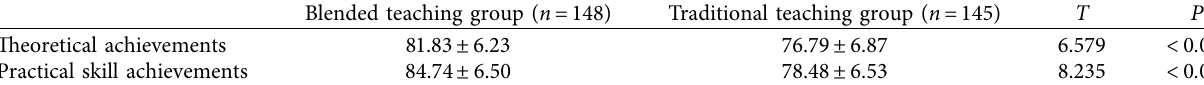
Table 1: Comparison of fnal examination results between the blended teaching group and traditional teaching group ( x ± SD, points).